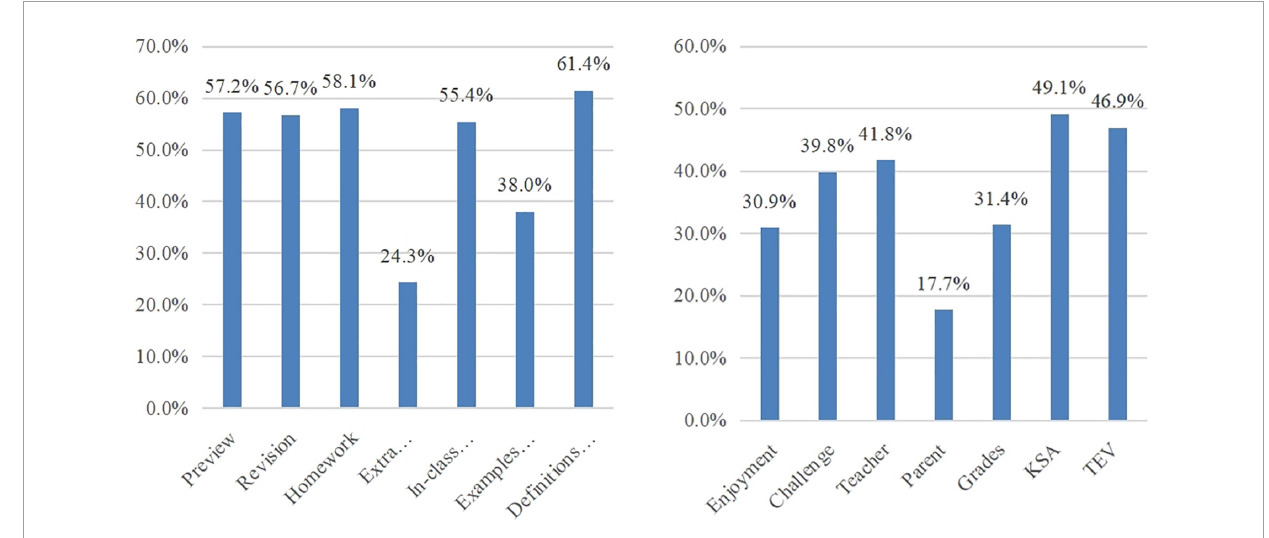
FIGURE4 Percentage distributions of the purposes and motivation of textbook use.